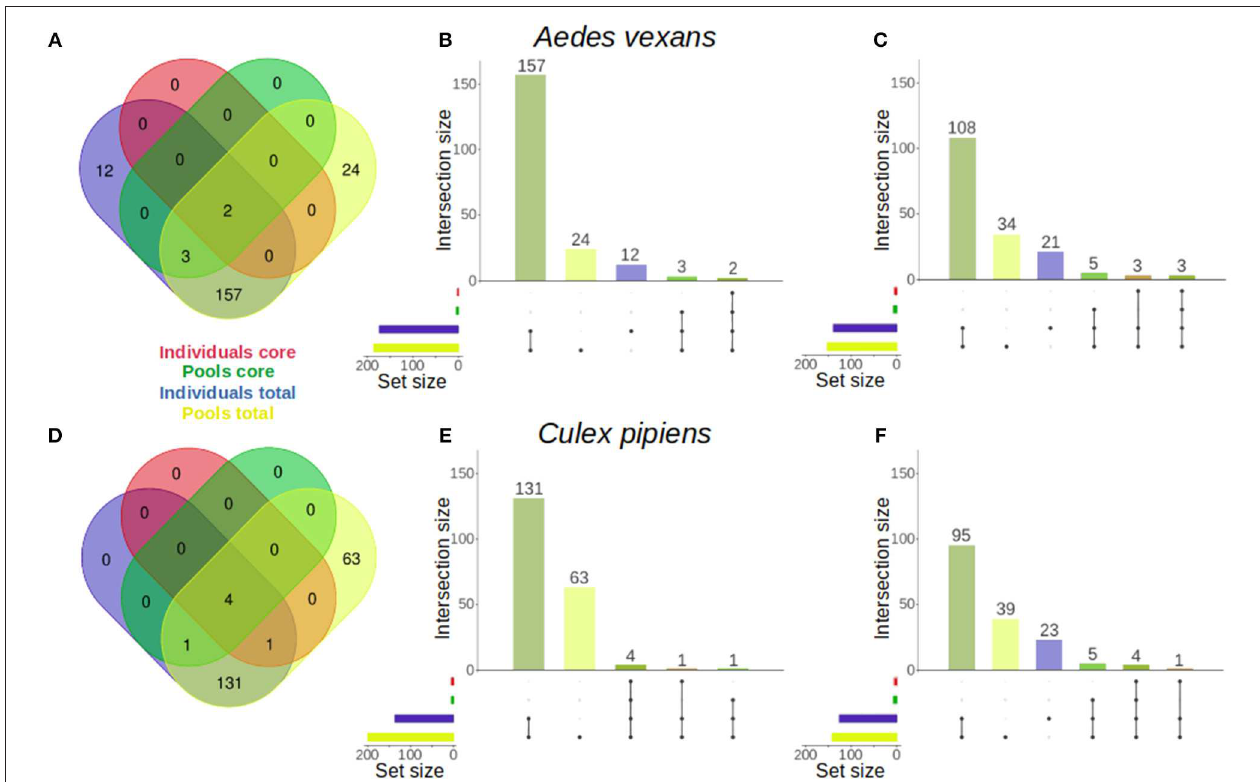
FIGURE 5 | Venn diagrams comparing the number of OTUs present in individual and pooled samples, both in total and in the core microbiome of (A) Aedes vexans and (D) Culex pipiens full data sets. Proportional representations (“Euler grids”) of the same information are given for the full data set (B,E) and the average values of the randomly sub-sampled data sets (C,F) of each